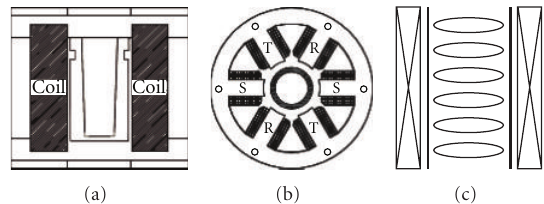
Figure 1: The schematic diagram of the apparatus with electro- magnetic stirrer: (a) Front view of EMS, (b) top view, (c) stirring direction.